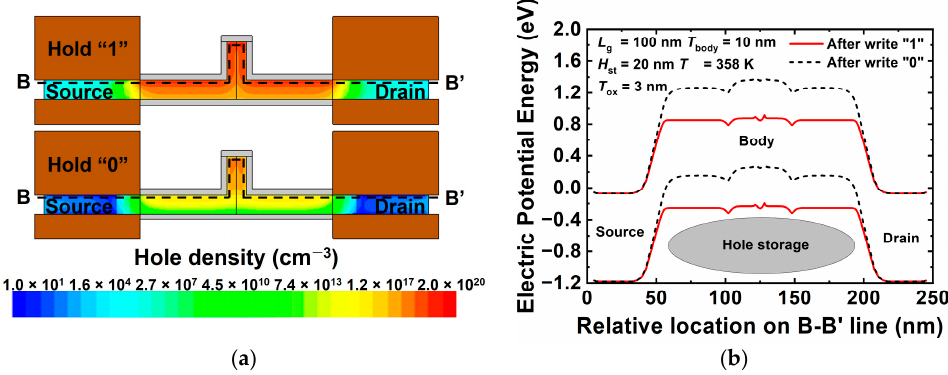
Figure 6. ( a ) Contour map of hole density and ( b ) energy band diagram of proposed 1T-DRAM cell in hold states “1” and “0” (energy band is extracted at 2 nm above gate 2 oxide). Figure 7a,b show the contour map of the electron density and energy band diagram of the proposed 1T-DRAM cell in the read “1” and read “0” operations. Note that a read operation is performed via the conventional MOSFET operation. Figure 7a shows that the electron density corresponding to read “1” is higher than that corresponding to read “0”, the inversion layer is formed on the side of gate 1 in the body region, and a current flows.